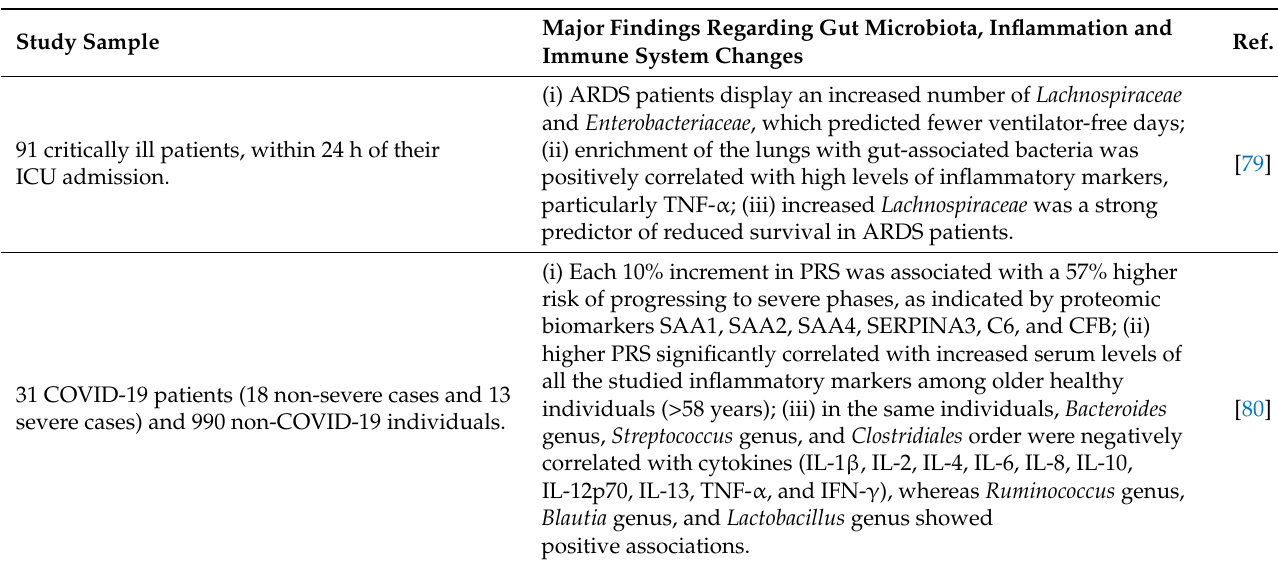
Table 1. Cont . Major Findings Regarding Gut Microbiota, Inflammation and Immune System Changes